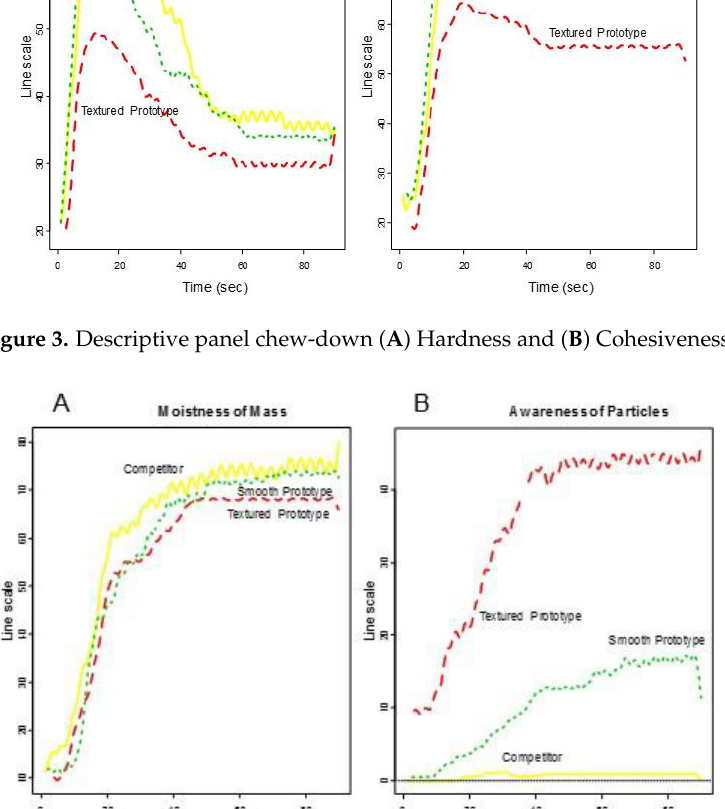
Figure 4. Descriptive panel chew-down ( A ) Moistness of Mass and ( B ) Awareness of Particles .